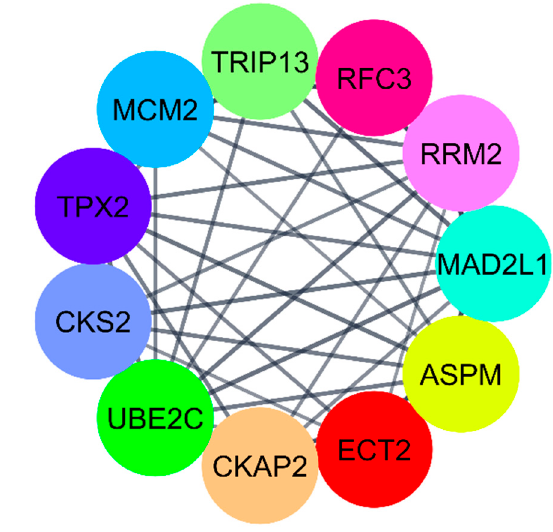
Figure 7. ( A , B ) The most significant modules of DEGs in G2. Cluster1 and Cluster2 were obtained with the MCODE plugin in Cytoscape.